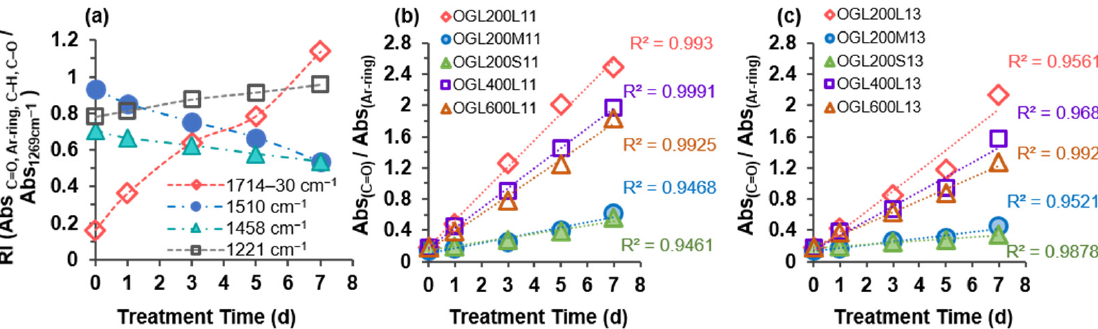
Figure 6. ( a ) Relative absorbance intensity (RI) of carbonyl (C=O) stretching; aromatic ring skeletal vibrations; C-H deformation in -CH 2 and -CH 3 ; and C-C, C-O, and C=O stretching of OGL200L13. ( b ) Absorbance ratio of carbonyl stretching and aromatic ring skeletal vibration of all OGL11 series and ( c ) OGL13 series as a function of H 2 O 2 treatment time.